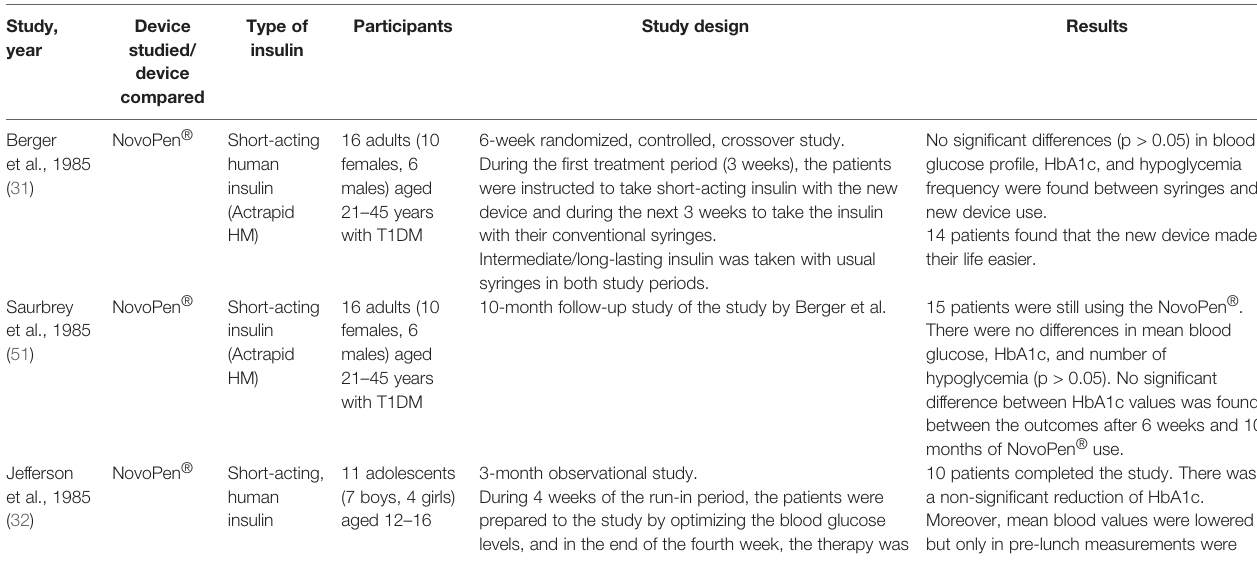
TABLE 1 | Reusable insulin